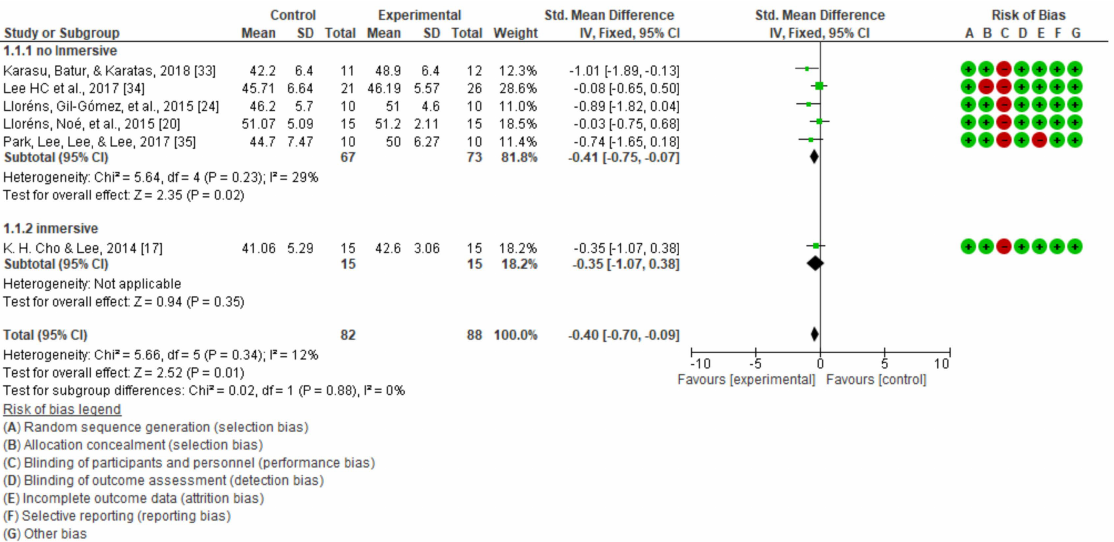
Figure 3. Static balance as measured using the Berg